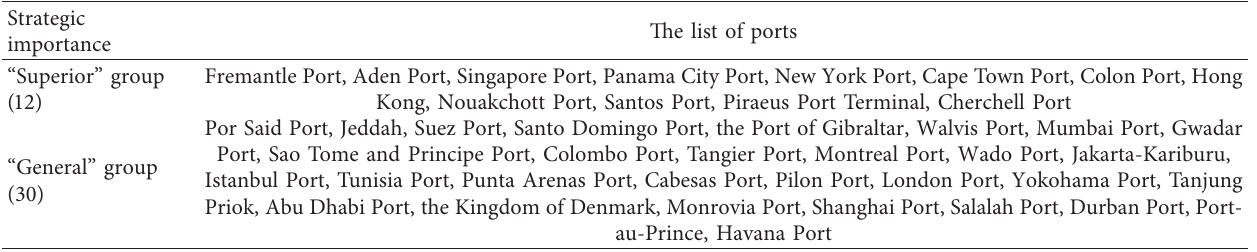
Table 6: Group results by interstitial central numerical training (ports in the “inferior” group are not listed; specific and available data can be searched or downloaded from the Table Port Betweenness Centrality in the following link: https://doi.org/10.4121/14298851).